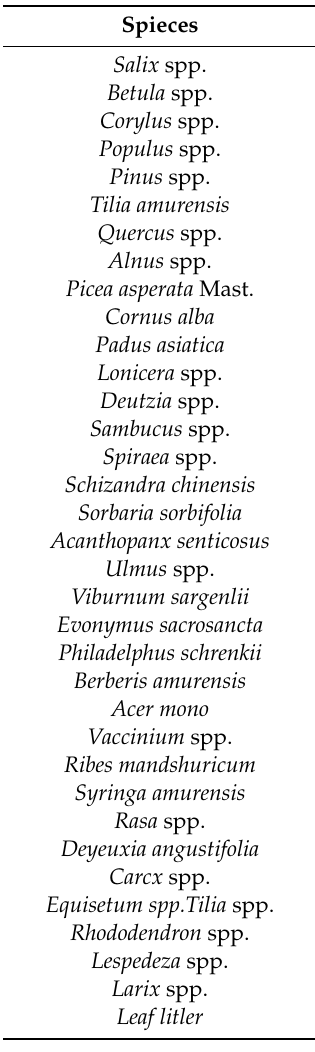
Table A1. Moose winter edible shrubs.